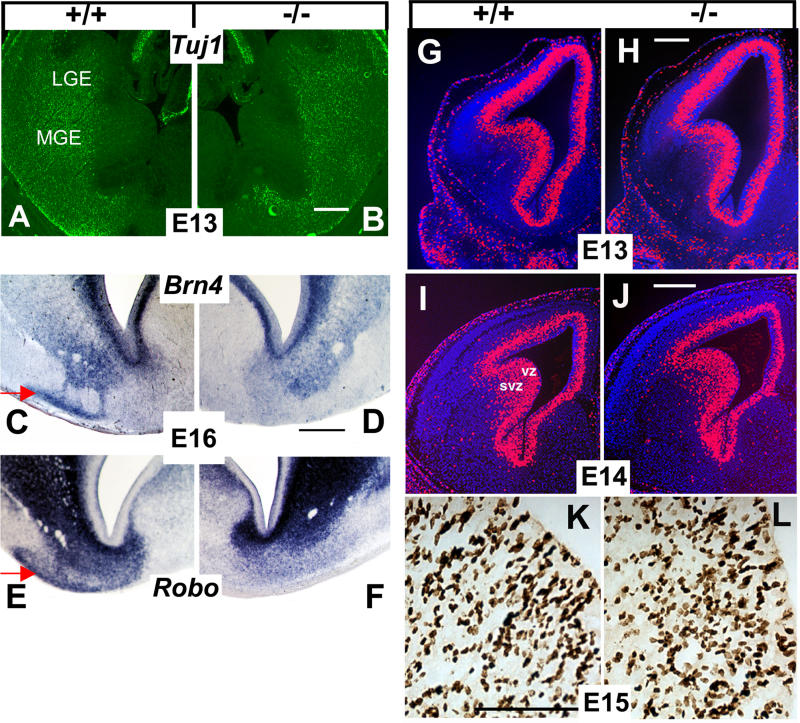
Normal Precursor Proliferation and Neurogenesis but Loss of OT Neuronal Differentiation in the Absence of SOX1Coronal brain sections from the ventral telencephalon of wild-type (+/+) and Sox1-null (−/−) embryos. TuJ1 immunolabeling (A and B) at E13 shows no difference in early neuronal differentiation embryos; in situ hybridization at E16 for Brn4 (C and D) and Robo (E and F) shows absence of differentiation in the mutant at the prospective OT area. Red arrow in wild-type brain sections indicates OT. Telencephalic sections of wild-type (G, I, and K) and Sox1-null mutant (H, J, and L) embryonic brains were harvested 1 h after BrdU injection at E13 (G and H), E14 (I and J), and E15 (K and L) to detect actively dividing cells of the VZ/SVZ. Positive cells were visualized with anti-BrdU immunofluorescence (G–J) or with DAB staining (K and L). (K and L) show dorsal LGE area at high magnification. No differences were detected in the proliferation precursors at all stages examined, and no ectopic proliferation was observed in the mutant brains. Measurements and statistical analysis of BrdU-positive cells were performed on the DAB-stained sections, showing no significant differences (see Table S1). Scale bar = 300 μm (A and B), 300 μm (C–F), 500 μm (G–J), 500 μm (K and L).